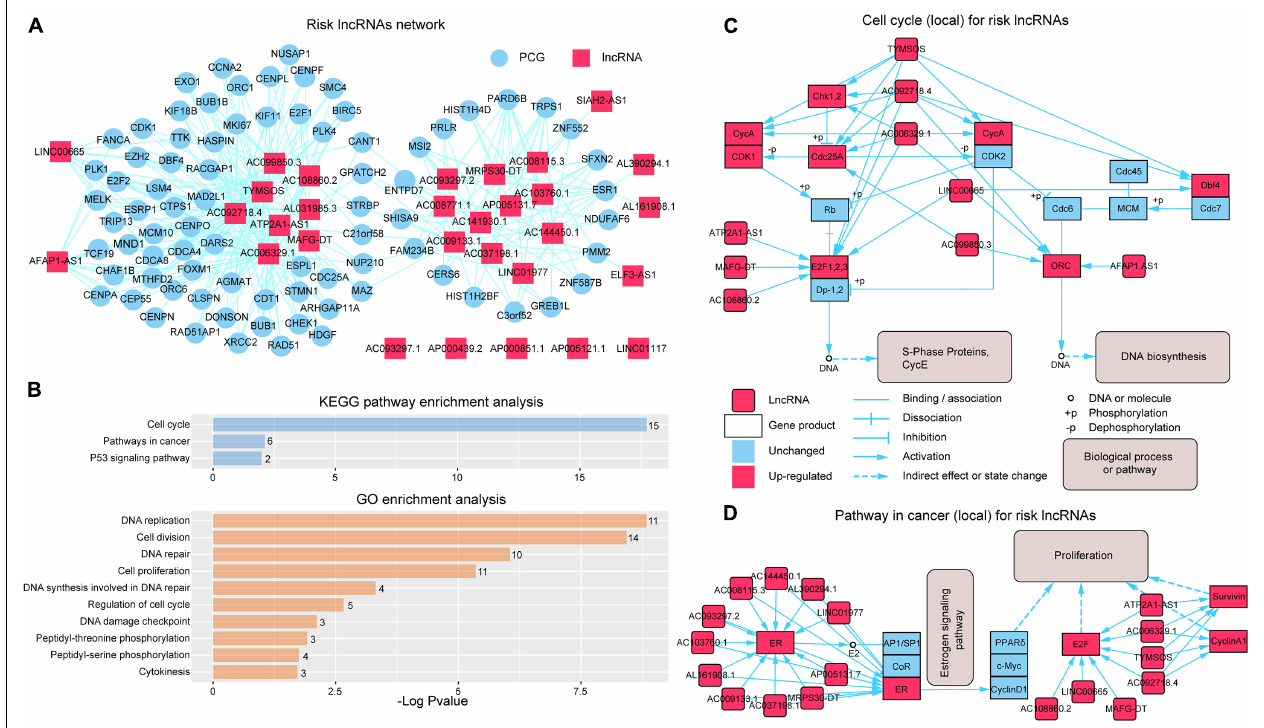
FIGURE 4 | Synergistic regulation of the risk lncRNAs. (A) Risk lncRNA network; PCGs regulated by more than three risk lncRNAs were selected. The red and blue nodes represent lncRNAs and PCGs, respectively. (B) KEGG and GO enrichment analysis was performed using genes in the risk lncRNA network. The X -axis shows the –log10 of the P -value; the Y -axis shows the names of the pathway/term. The number at the top of the bar indicates the number of PCGs annotated to the pathway/term. (C) Risk lncRNAs regulate the cell cycle pathway (local). (D) Risk lncRNAs regulate the pathway in cancer (local).